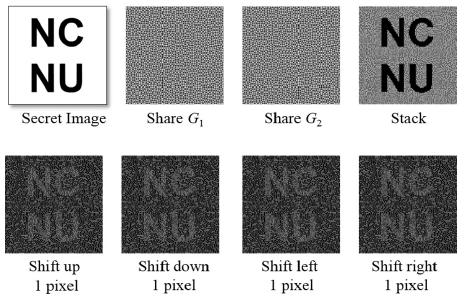
Figure 4. The experimental results for n = 3.